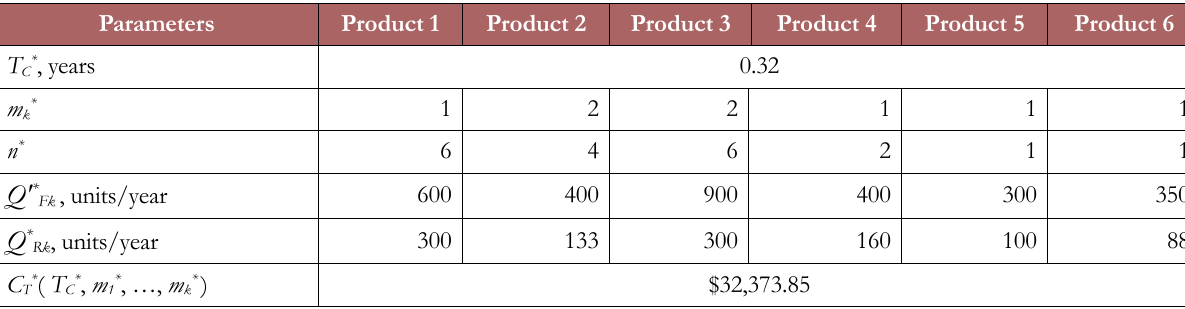
Table 4. Optimum results for raw materials of imperfect matching